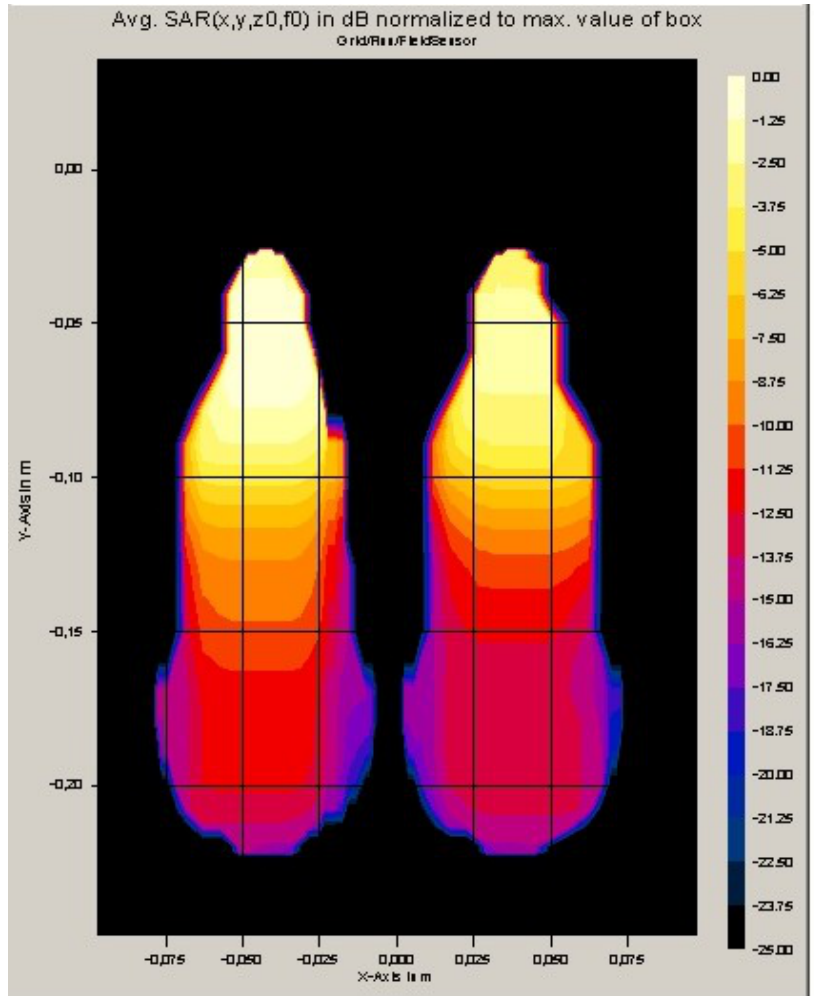
FIGURE 3 . Distribution of the absorbed power by the rats as calculated by the FDTD